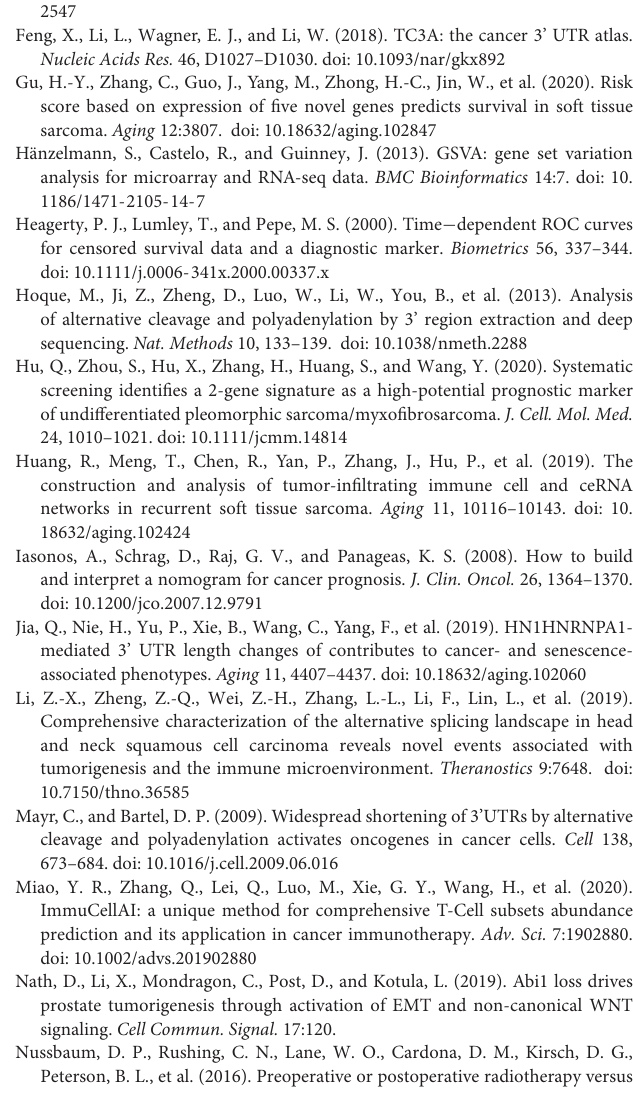
Supplementary Figure 1 | LASSO analysis of OS- and PFS-related APA events. (A,C) Dotted vertical lines were drawn at the optimal values by using the minimum criteria. (B,D) LASSO coefficient profiles of the candidate OS (B) and PFS (D)- related alternative polyadenylation events. A coefficient profile plot was produced against the log λ sequence. LASSO, least absolute shrinkage and